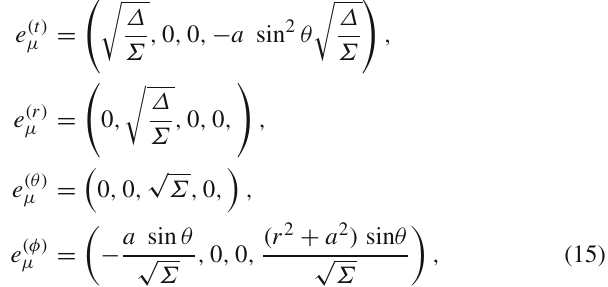
Fig. 2 The bounds on the rotation and the tidal charge parameters are shown for rotating braneworld BH Here the tetrad frame of covariant vectors e